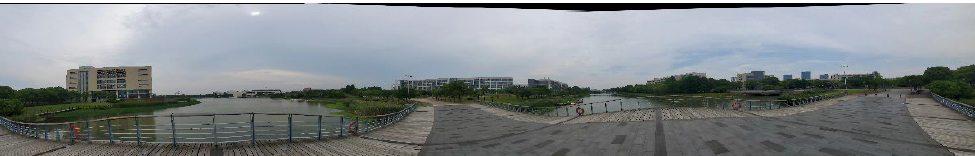
Figure 12. Result obtained with the MSIS method.